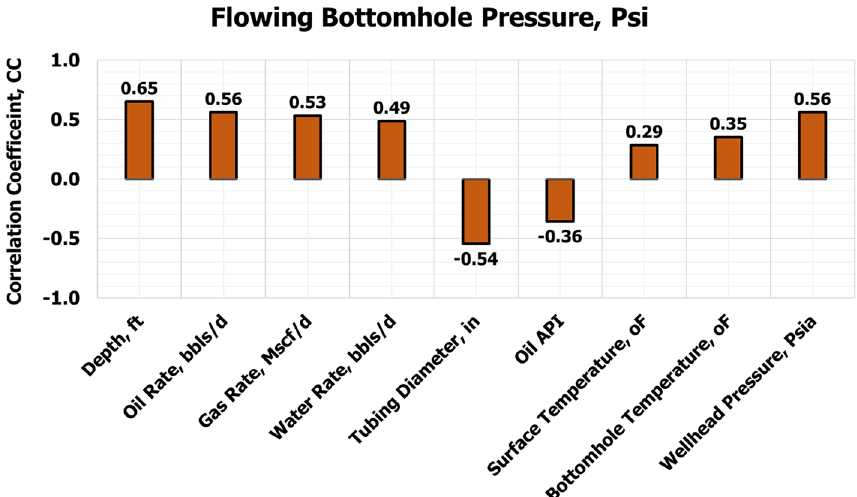
Fig. 1 Relative importance of input parameters with flowing bottom-hole